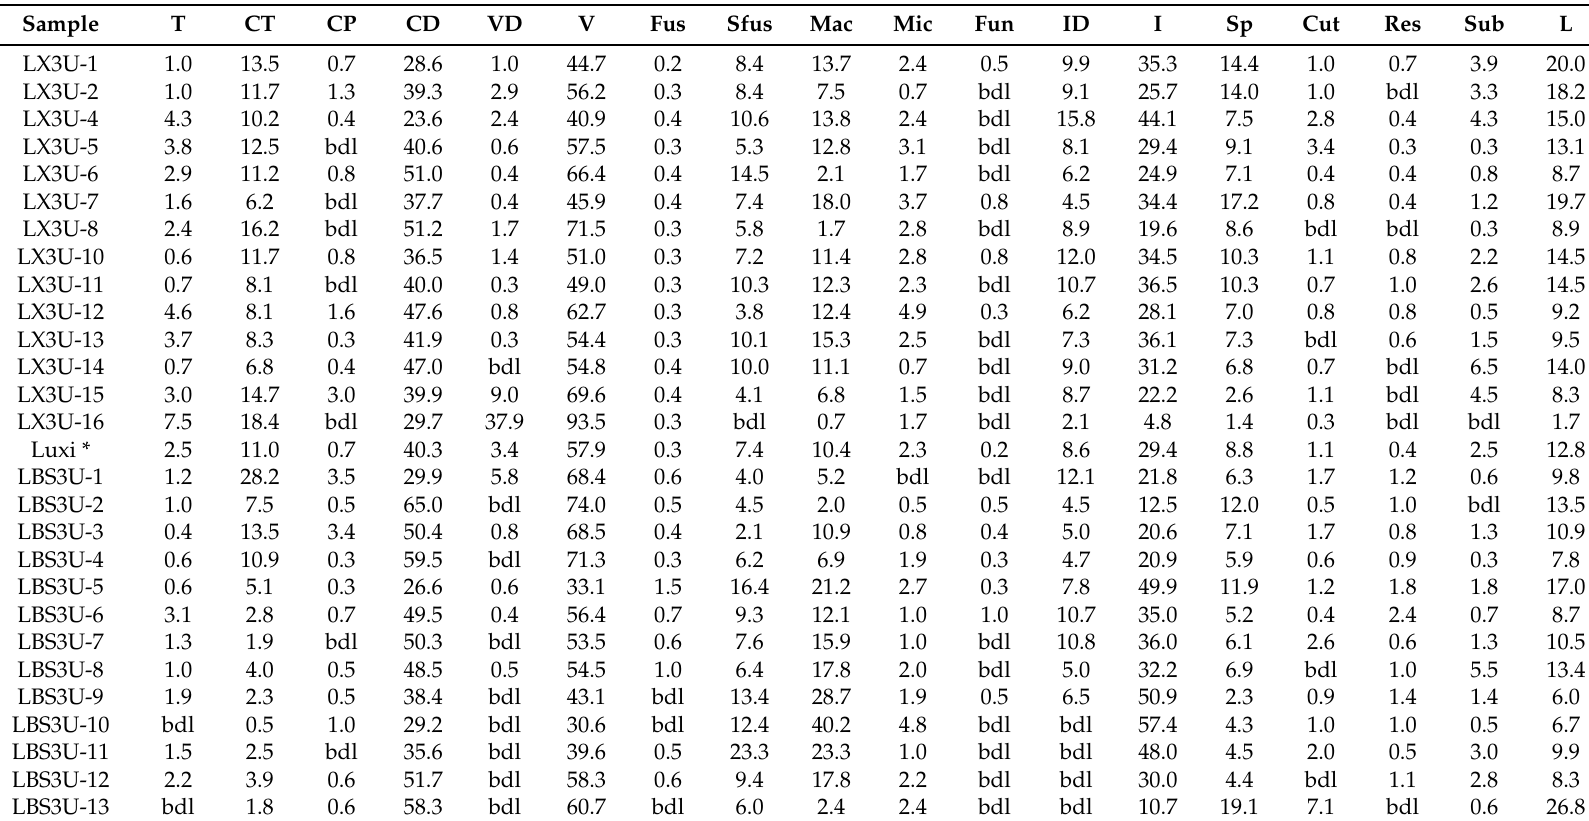
Table 2. Maceral compositions of the Upper No. 3 coals from the Luxi, Liangbaosi, and Tangkou mines, southwestern Shandong, China (vol %; on mineral-free basis).